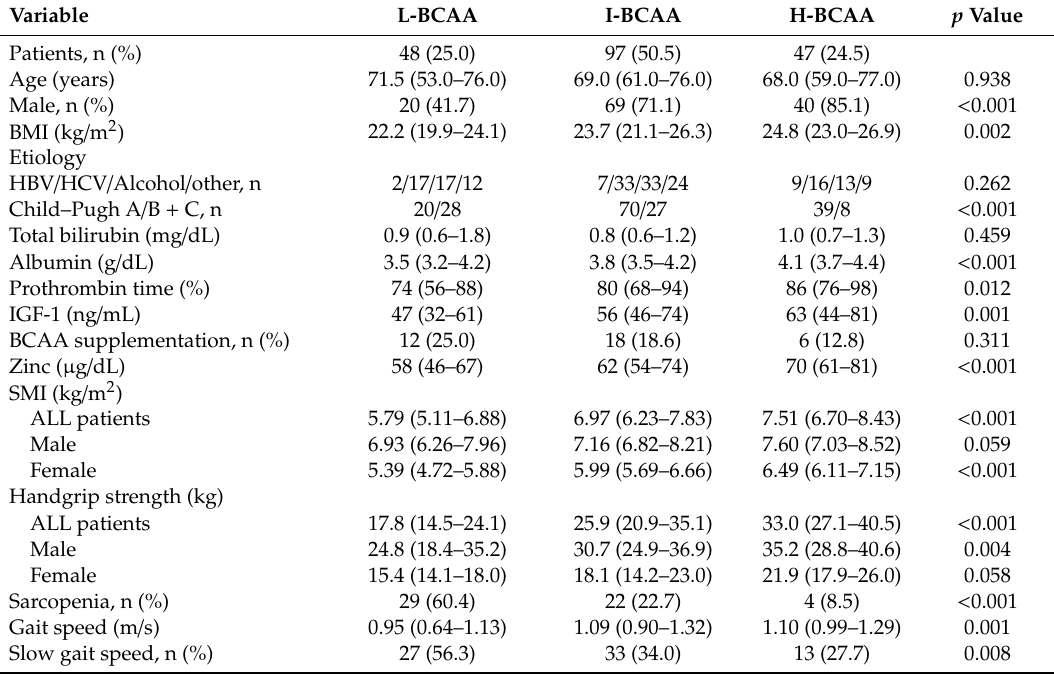
Table 3. Characteristics of the three groups based on serum BCAA